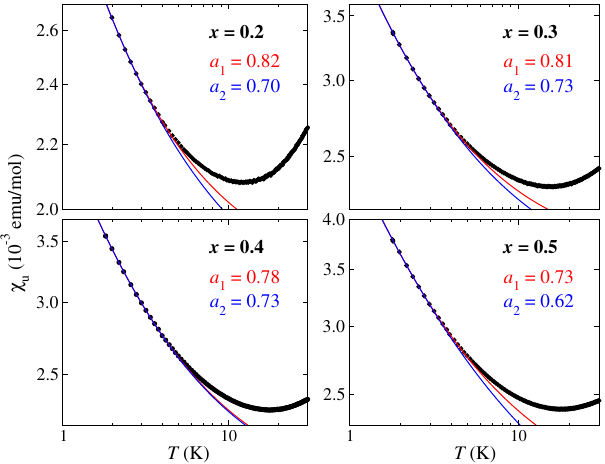
FIG. 29. Experimental susceptibility data (black circles) for the random quantum magnet Sr 2 CuTe 1 − W O 6 from Ref. [25]. x x The panels correspond to W fractions x ¼ 0 . 2 , 0.3, 0.4, 0.5, as indicated. Logarithmic scales are used for all axes. The curves are − a , with red and blue corresponding, χ of the form χ 0 þ cT u ¼ respectively, to T < 4 K and T < 3 K data used in the fits. The temperature exponents ( a 1 for T < 4 K and a 2 for T < 3 K) obtained from the fits are also indicated in the